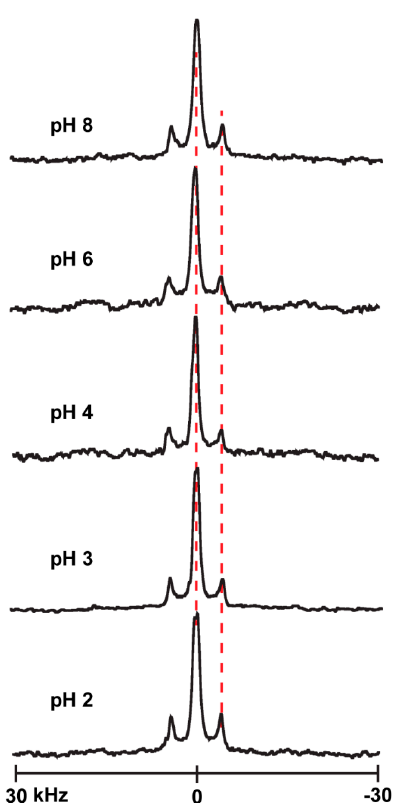
Figure 9. Selected 2 H NMR spectra to show the pH dependence of resonances for labeled A7 and A9 of GH 5,19 ALP23 in DOPC lipid bilayers. Temperature 50 °C; β =90° sample orientation.